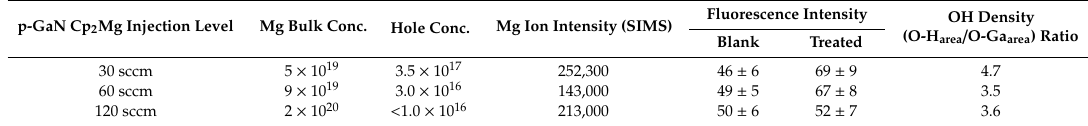
Table 3. Mg bulk concentration, hole concentration, Mg ion intensity at the surface, mean fluorescence intensity (mean value ± standard deviation in arbitrary units; exposure—25 s; gain kept at 10 for all images) and OH density ratio of the protein functionalized substrates. The latter was estimated from the ratio of the deconvoluted O (1s) intensities in the XPS spectra corresponding to O-H and O-Ga species. Conc. means concentration per cm 3